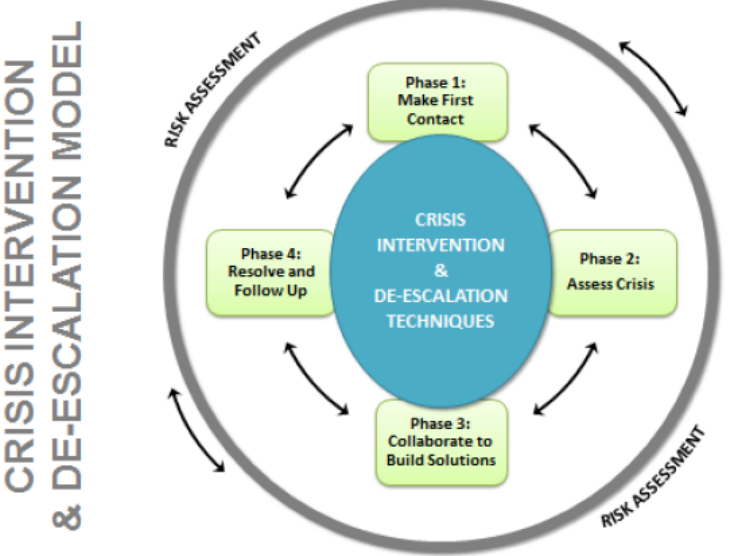
Figure 3. BC-CID Model. From [6] (p. 34) with permission from The Office of the Ombudsman of Ontario.